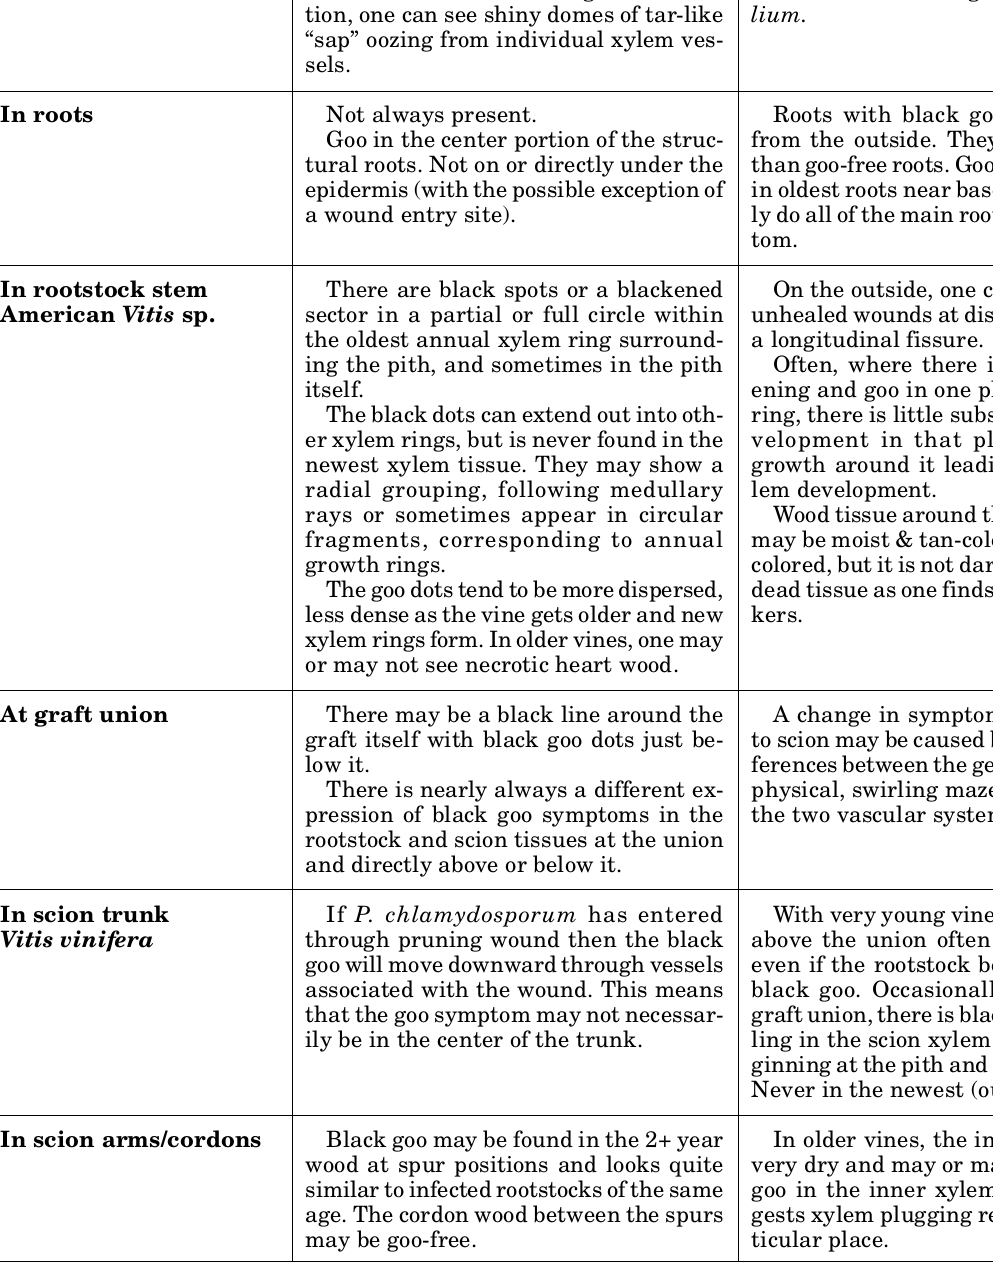
Table 1. Updated summary of “black goo” a symptoms found inside woody tissue (from Morton, 1995). LOCATION Only in wood > 1 year Black goo under 10 x magnifier (all